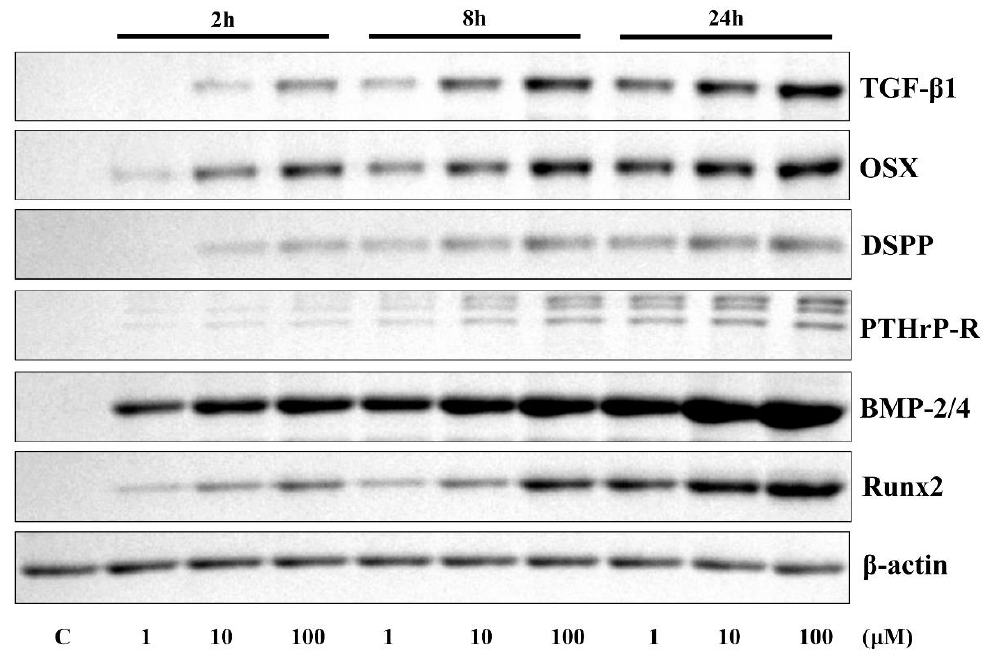
Figure 1. Results of western blotting assay for cell culture. Application of 4-hexylresorcinol (4HR) increased the expression levels of TGF- β 1 (transforming growth factor-beta 1), OSX (osterix), DSPP (dentin sialophosphoprotein), PTHrP-R (parathyroid hormone-related protein receptor), BMP-2 / 4 (bone morphogenic protein-2 / 4), and Runx2 (runt-related transcription factor 2) in a time- and dose-dependent manner.